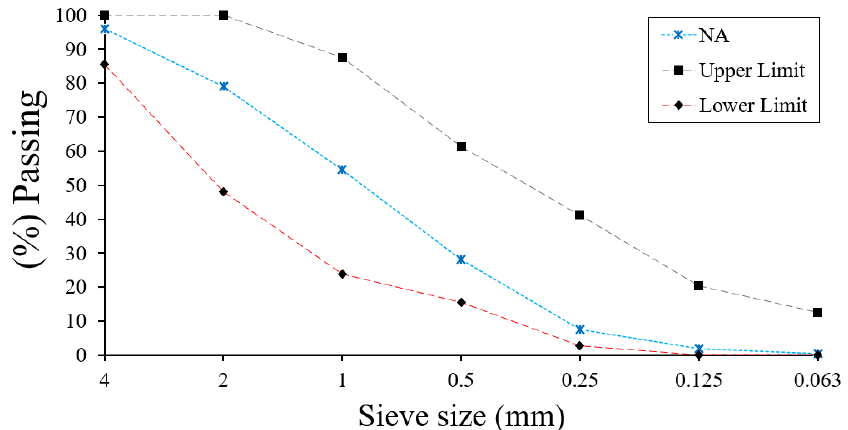
Figure 1. Recycled aggregate size distribution curve compared to the limits of NBE FL-90 [47] adapted to sieve size established by UNE-EN-933-2 [45].